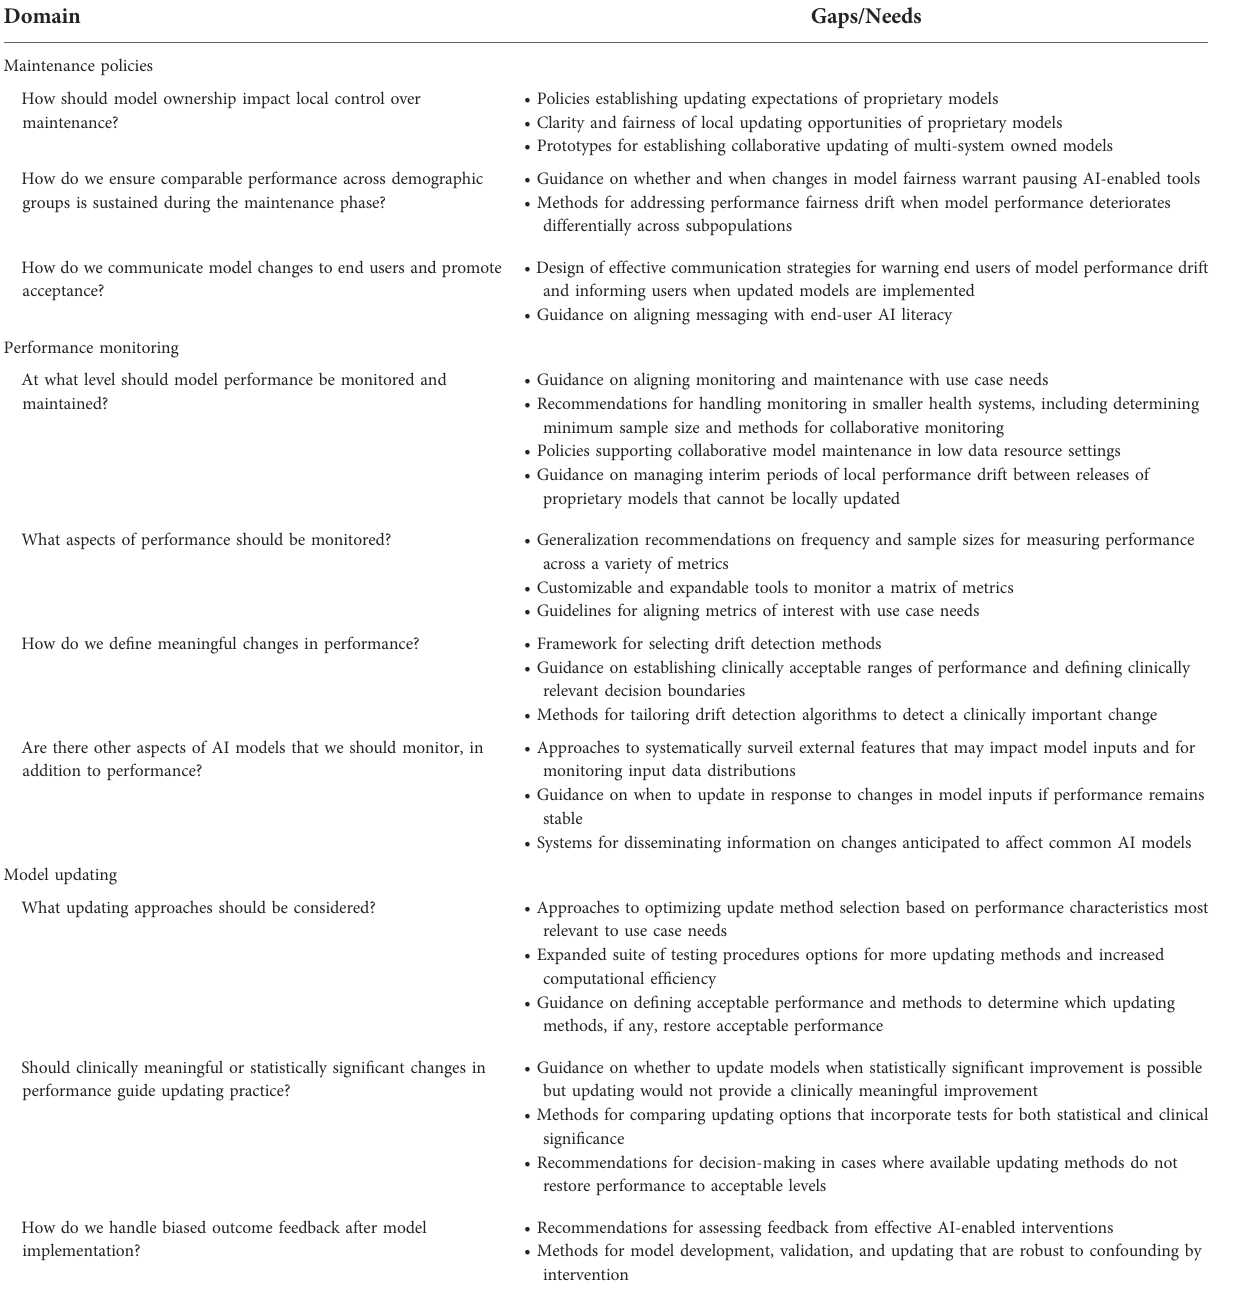
TABLE 2 Overview of gaps in best practices for model